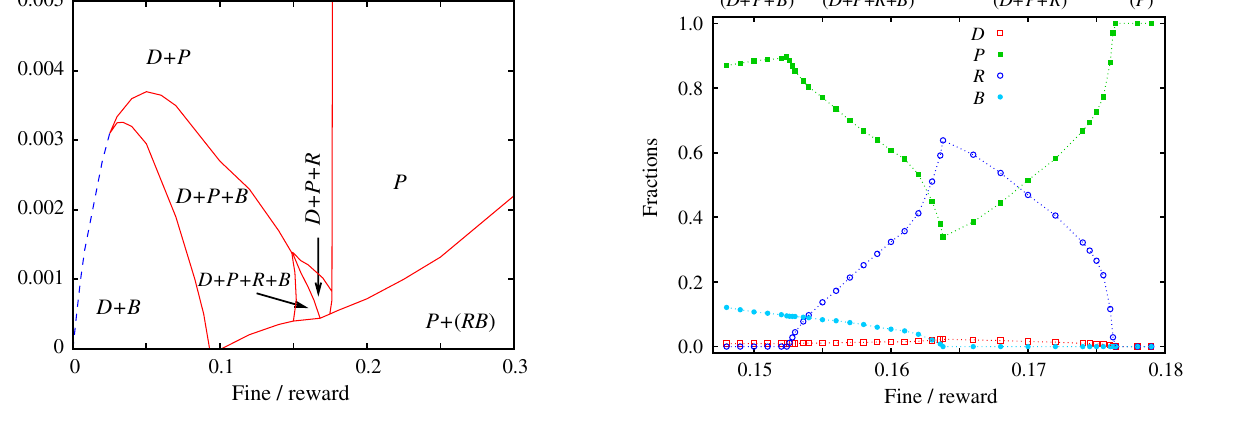
FIG. 3. Cross section of the phase diagram depicted in Fig. 2, as obtained for (cid:2) ¼ 0 : 0007 . Depicted are stationary fractions of the four competing strategies in dependence on (cid:1) . Stable solutions are denoted along the top axis. Unlike the D þ P ! D þ B phase transition, denoted by a dashed blue line in Fig. 2, in this cross section, all phase transitions are continuous.